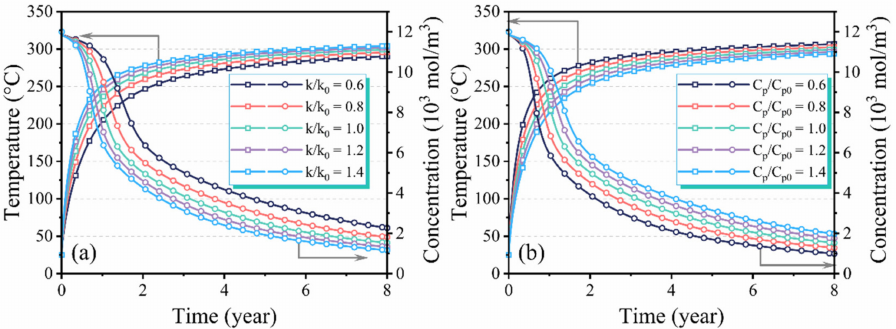
Figure 7. Effect of thermophysical properties of oil shale on average reservoir temperature: ( a ) thermal conductivity; ( b ) heat capacity.